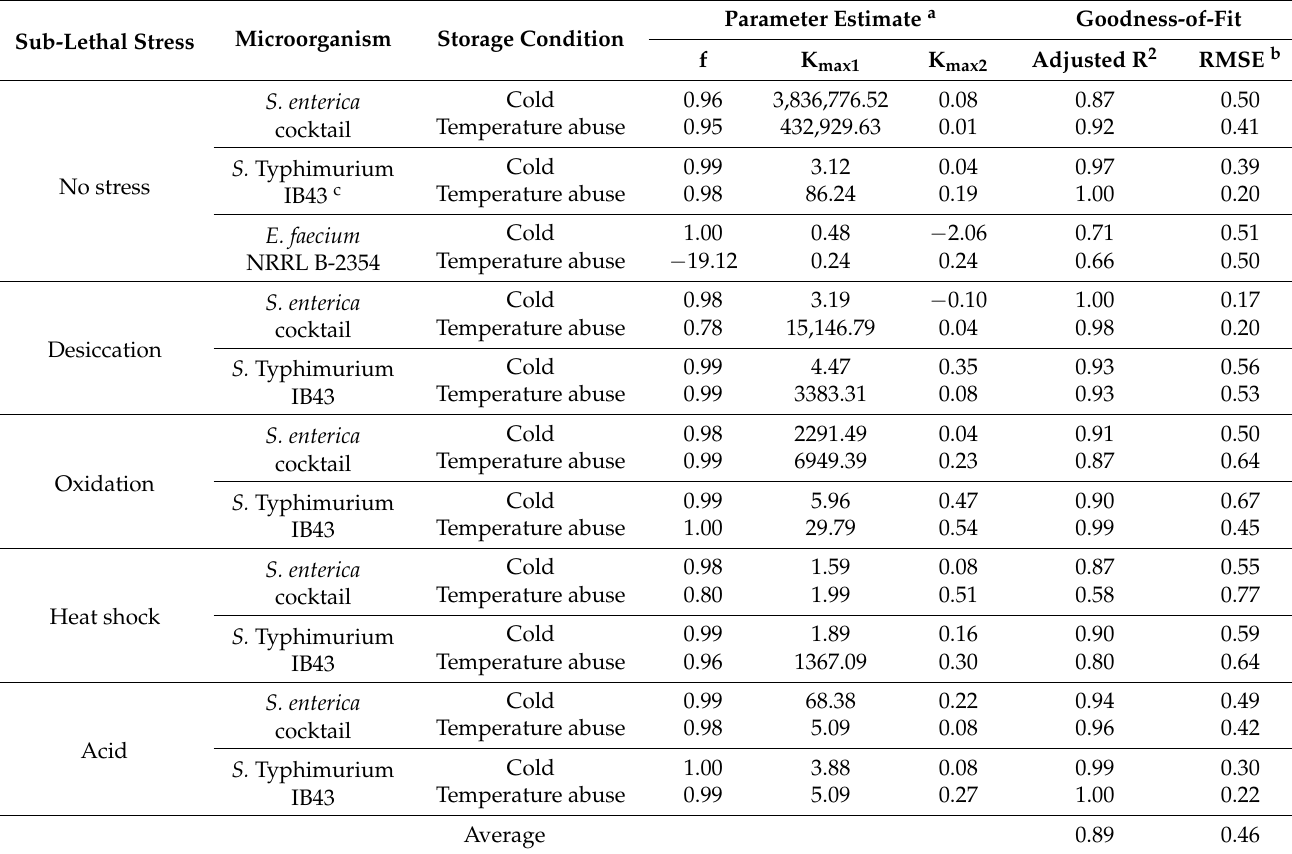
Table 5. Parameter estimates and goodness-of-fit of the biphasic model for the persistence of S. enterica and E. faecium NRRL B-2354 on baby spinach under cold and temperature abuse conditions with or without prior exposure to sub-lethal stresses. Sub-Lethal